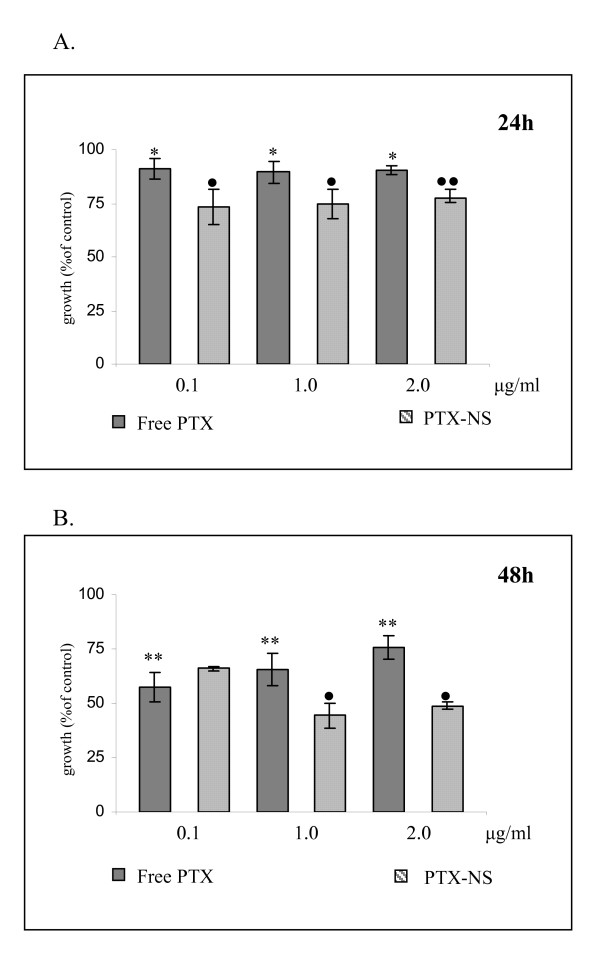
Cytotoxicity of free PTX and PTX-NS in MDA MB231 cells. MDA MB231 cells were treated with increasing concentrations (0.1 – 2.0 μg/ml) of either free PTX or PTX-NS for 24 (6A) or 48 (6B) h and cell viability assessed by the MTS assay. Data are expressed as % of viable cells (mean ± SD of three separate experiments, each performed in triplicate) exposed to PTX in respect to untreated controls. • free PTX vs. PTX-NS, *treated vs. not treated *p < 0.05 ••**p < 0.01